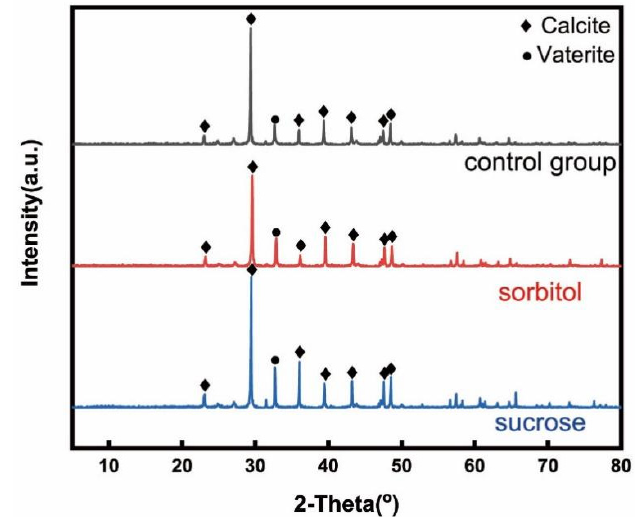
Figure 9. XRD analysis results of CaCO 3 .precipitation.